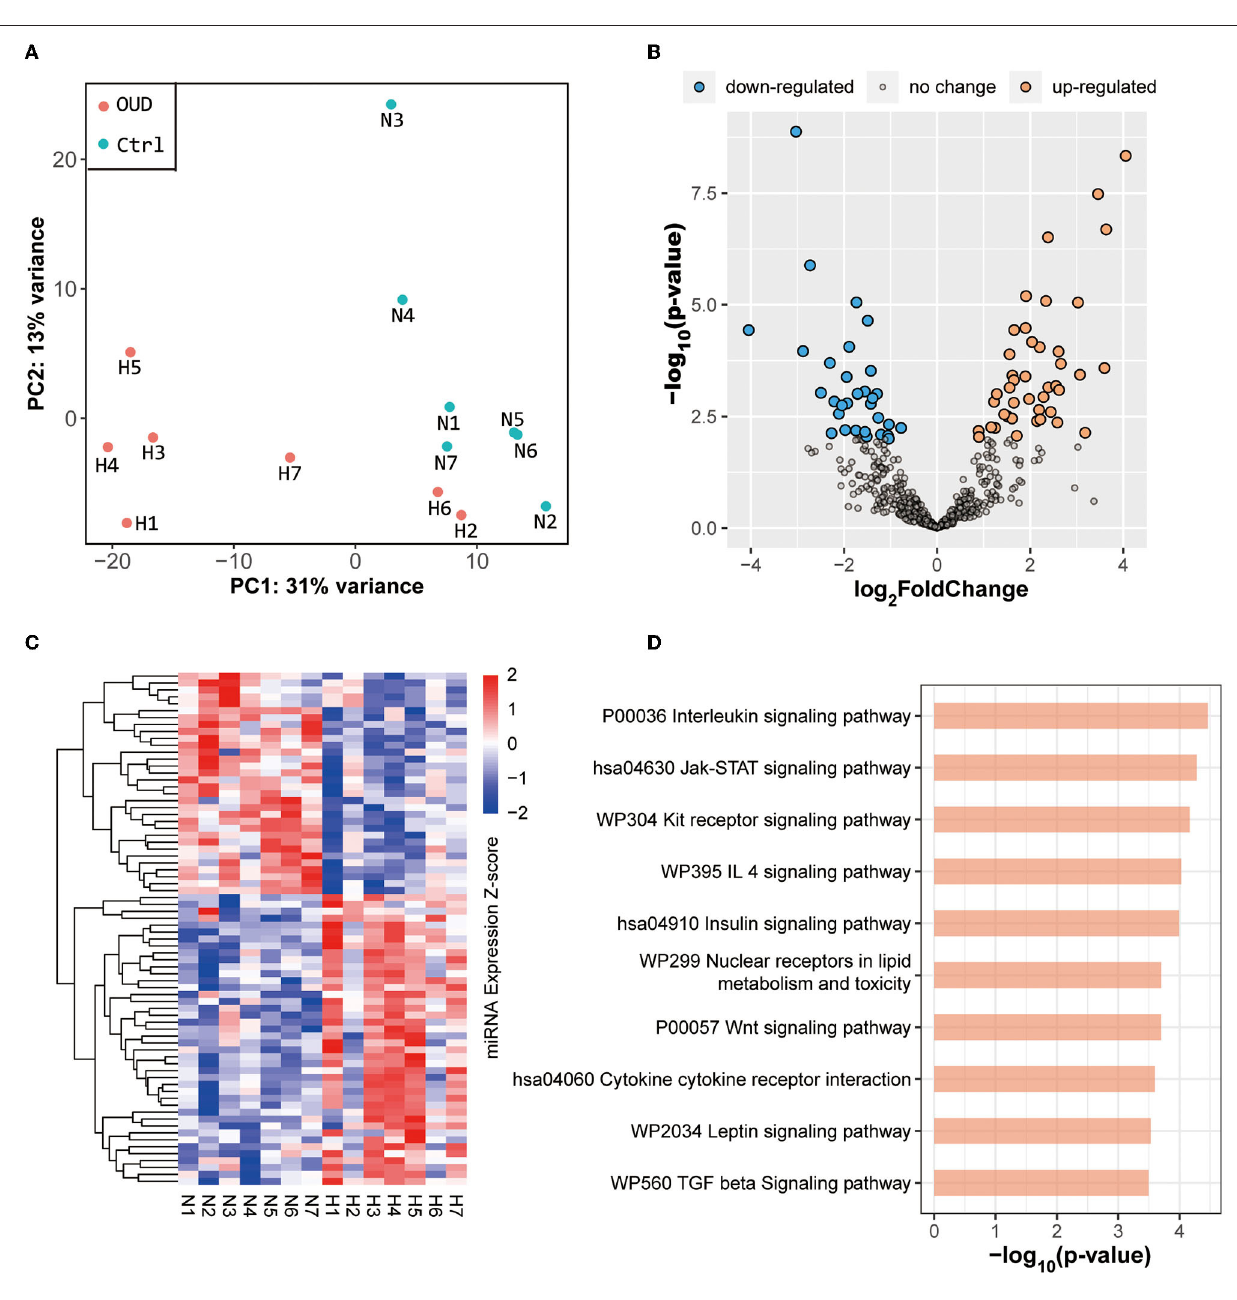
FIGURE 2 | Results of small RNA sequencing. (A) Principal component analysis results of all samples. The red dot in the figure represented the OUD group and blue dot represented the control group. (B) Volcano plot of all expressed miRNAs. We set the threshold of differential expression as |log 2 FoldChange| > 1.5 & p -value < 0.01. The blue dot, orange dot and gray dot represented the down-regulated miRNAs (OUD/Control), up-regulated miRNAs and non-significant changed miRNAs, respectively. (C) Expression heatmap of all differentially expressed miRNAs. (D) KEGG enrichment result of targeted genes predicted by differentially expressed